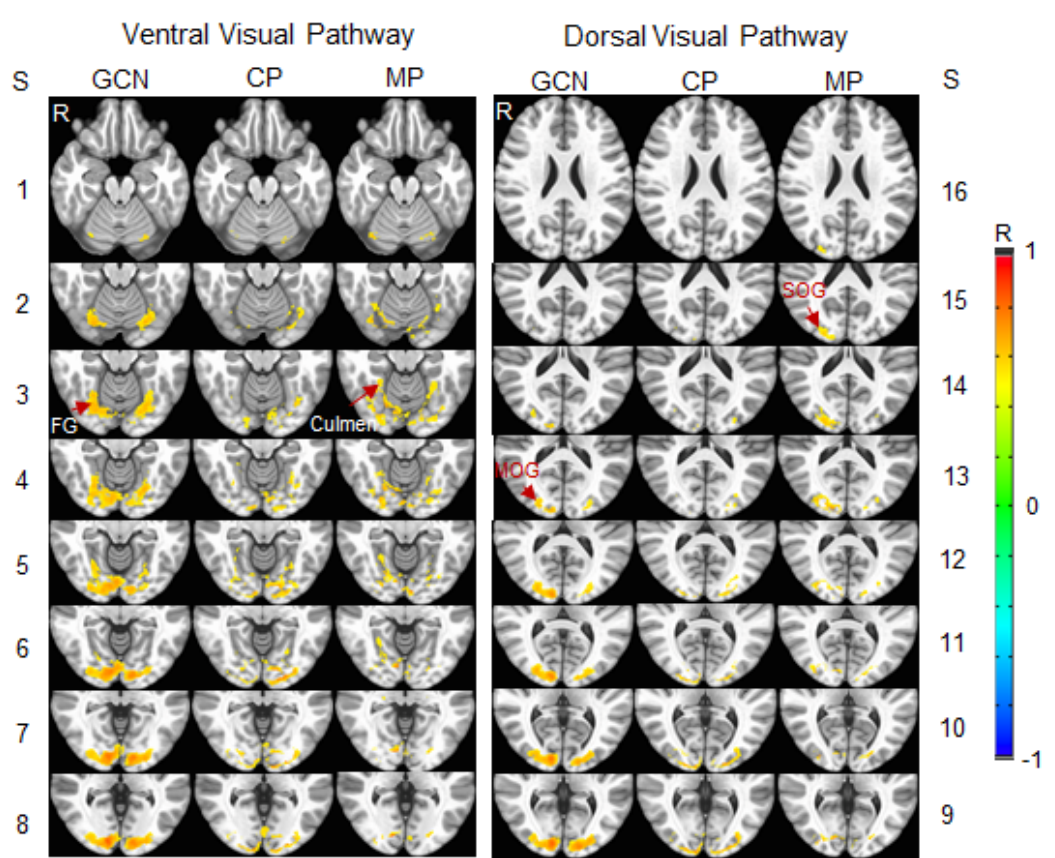
Figure 7. Illustration of the stimulation-evoked visual cortical functional network for the migraine patients (MP) versus the control participants (CP). 1st & 4th columns: the grand-common network (GCN) shared by both networks of the two participant groups in ventral and dorsal visual pathways; 2nd & 5th: CP network distinct from the GCN; and 3rd & 6th: MP network distinct from the GCN. Note that, for each of the two distinct networks, the union of that distinct network with the GCN is the visual cortical functional network of that participant group. Slice (S) thickness 1 mm with 2 mm gap between any two adjacent slices. R: right; FG: fusiform gyrus, Brodmann area (BA) 19; Culmen: BA 37; MOG: middle occipital gyrus, BA 18; and SOG: superior occipital gyrus, BA 18.